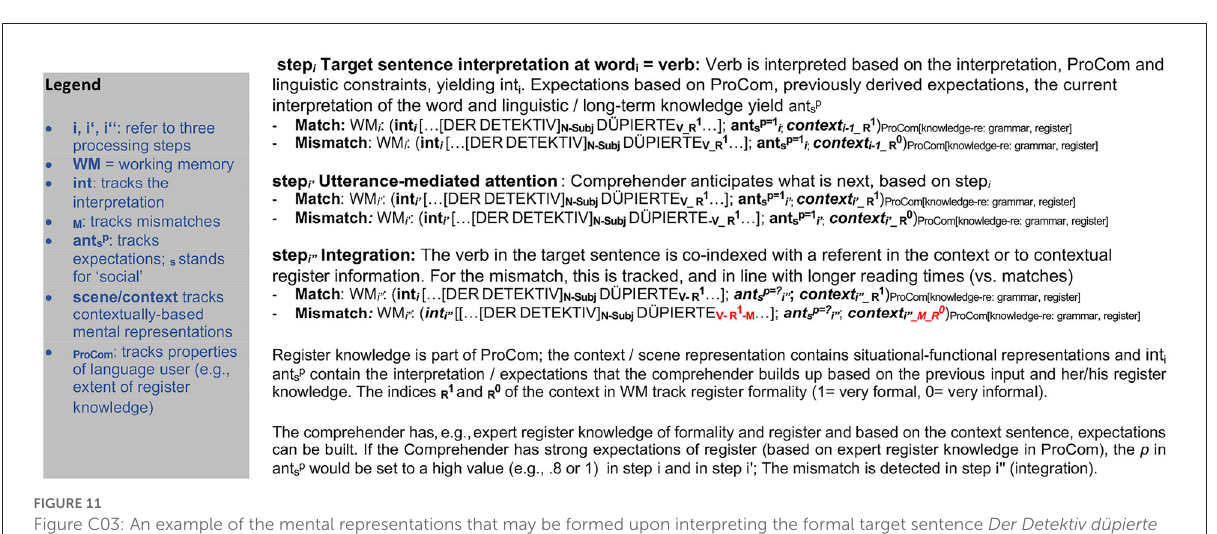
FIGURE11 Figure C03: An example of the mental representations that may be formed upon interpreting the formal target sentence Der Detektiv düpierte den Gauner (“The detective duped the villain”), preceded by either a formal, register-matching or an informal, register-mismatching context.